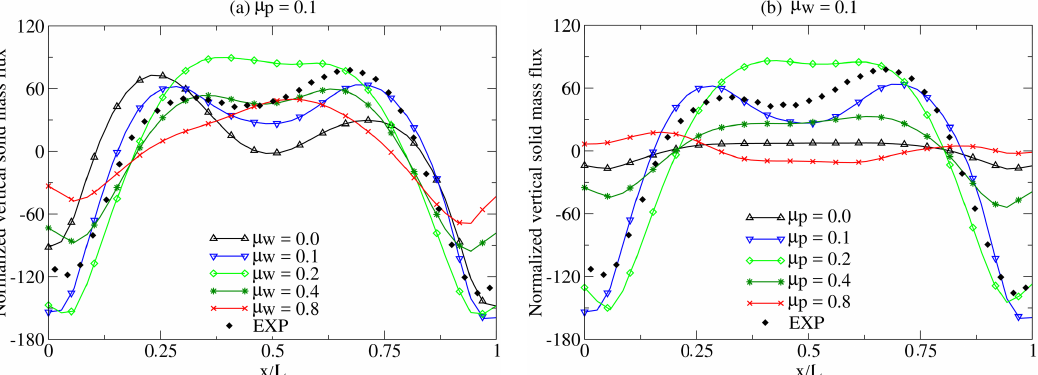
Figure 18. Time-averaged vertical solid mass flux normalized by the gas mass flow rate, < α p ρ p U p > xz / ρ U f , for different values of the particle–wall and particle–particle friction coefficients, ,3 and comparison with experiments. Re p = 70 and bed weight 75